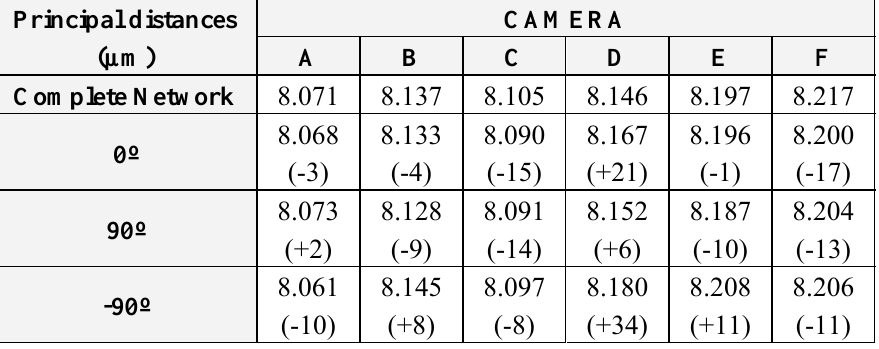
Table 6. Principal distances according to the different subnets.